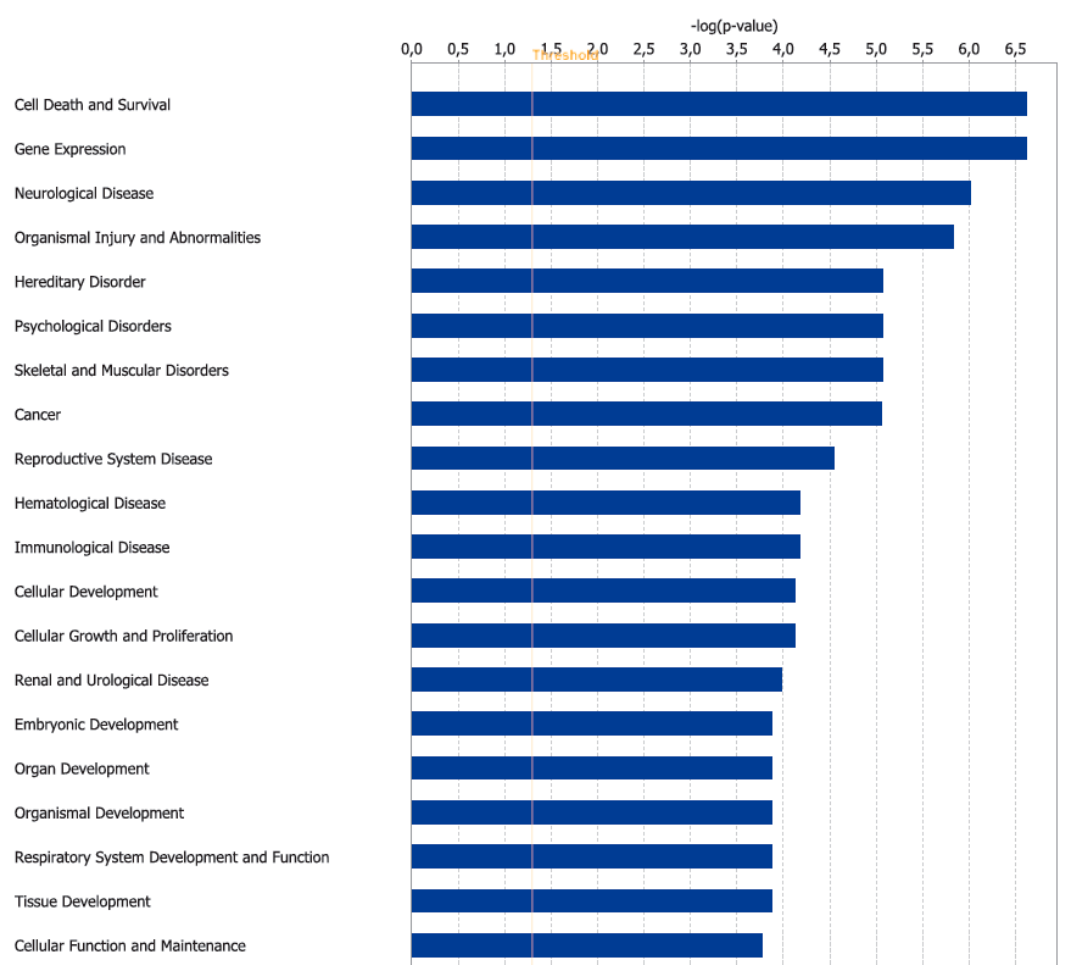
Figure 3. Top 20 diseases and biological functions enriched by the IPA "Core Analysis" for the 25 genes differentially expressed between the CTRL and RS groups.